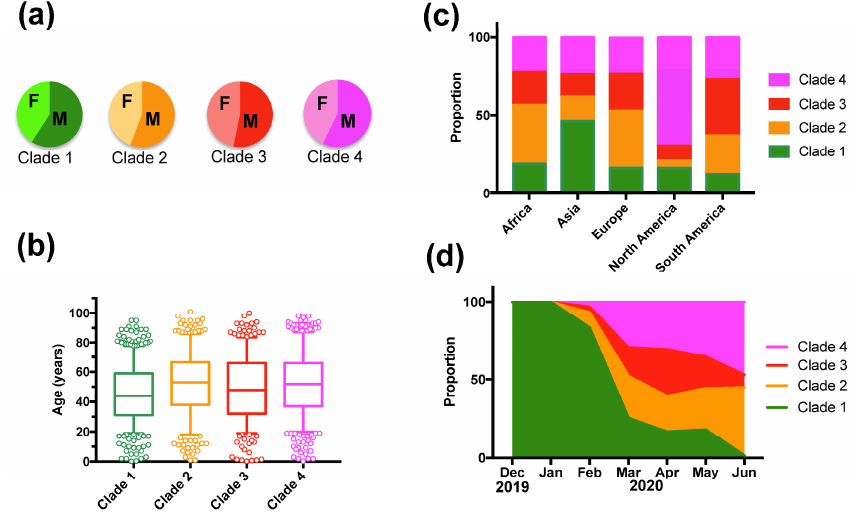
Figure 2. Patient sex-ratio, geographic and temporal distribution of SARS-CoV-2 clades. ( a ) There were no significant variations in patient sex-ratio among clades (X 2 = 4.02, d.f. = 3, p = 0.26). ( b ) Patient age distribution among Clades was similar, although patients from Clade 1 were significantly younger (Tukey post hoc test, p < 0.01). ( c ) Geographic regions presented significant differences in Clade proportion (X 2 = 522.65, d.f. = 12, p < 0.0001). ( d ) The proportion of Clades varied significantly over time (X 2 = 821.54, d.f. = 18, p < 0.0001).